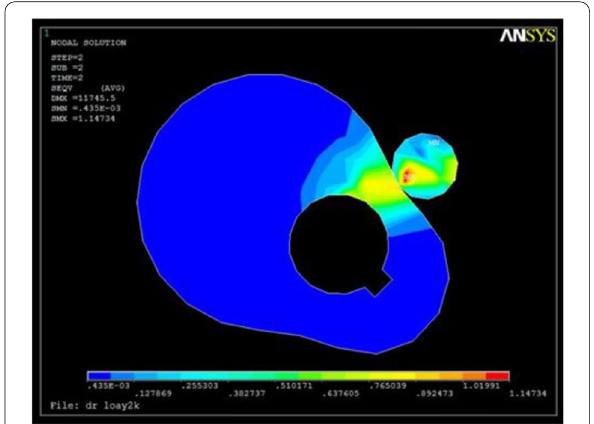
Figure 22 Contact stress contour when the follower located at 90° with the cam